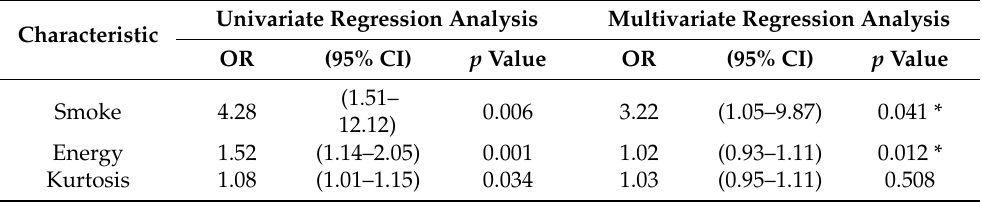
Figure 4. Comparison between IPF patients with and without lung cancer. ( A , B ) Images from an 87-year-old man who was a heavy smoker with IPF. (4A) HRCT showed an adenocarcinoma in the middle lobe of the right lung. ( B ) Whole-lung texture analysis revealed energy: 2.56 × 10 12 and Kurtosis: 29.13 ( C , D ) Image from a 74-year-old woman who was a nonsmoker and was diagnosed with IPF. ( C ) HRCT showed pulmonary fibrosis without lung cancer ( D ) Whole-lung texture analysis revealed energy: 1.21 × 10 12 and Kurtosis: 17.62. Table 3. Univariate and multivariate logistic regression model to differentiate cancer-developing ILD from non-cancer ILD in the training